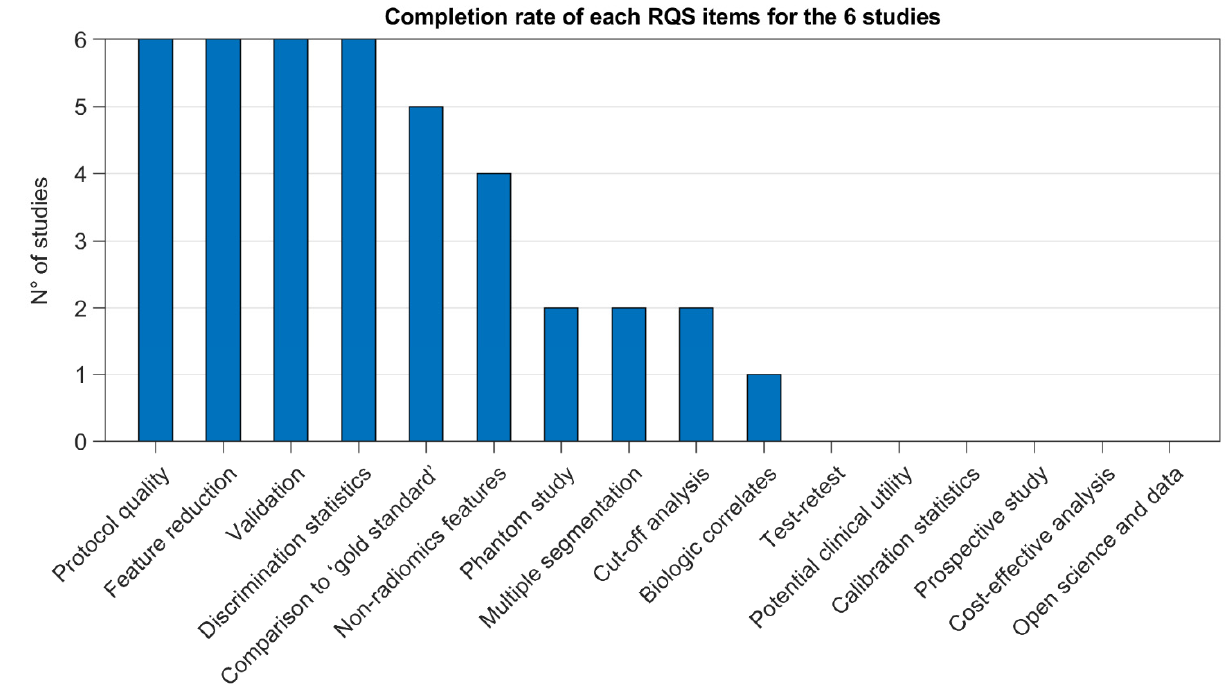
Figure 2. Completion rate of each item of the RQS metric considering all studies. Items evaluate six different domains, i.e., protocol quality, feature selection and validation, clinical validation and utility, model performance, study level of evidence, and open science.